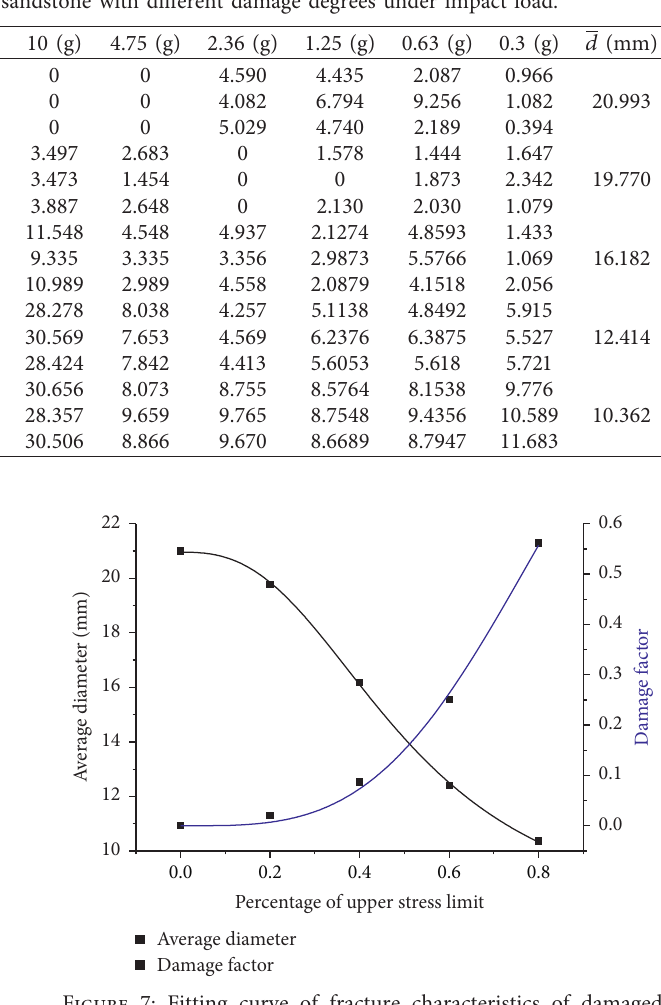
Figure 6: Curve of fitting relationship between the average di- ameter of broken rock block and the upper stress limit.